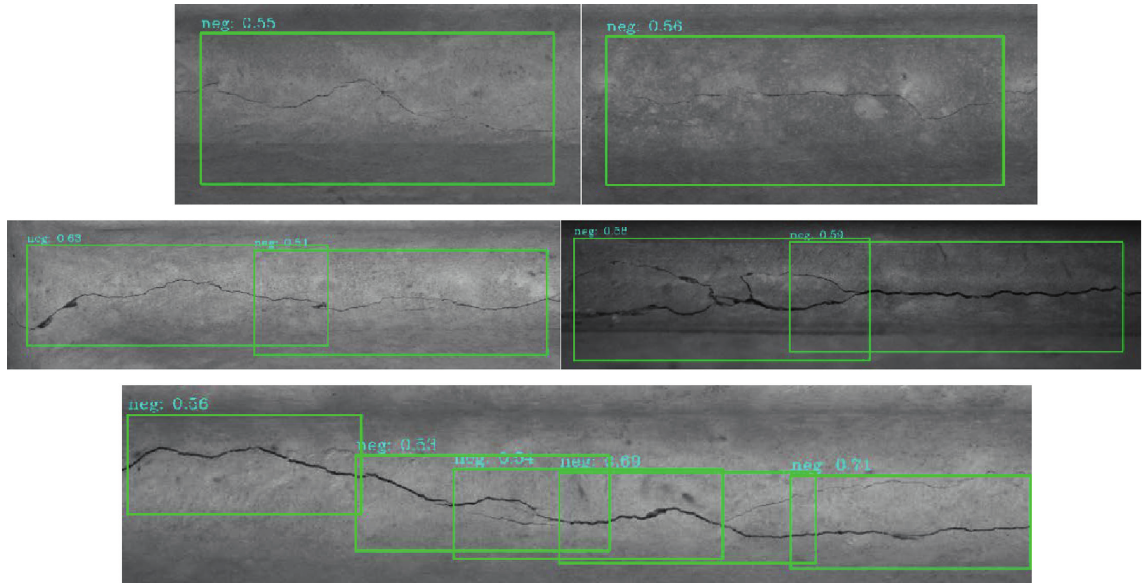
Figure 8: Detection results of cracks.